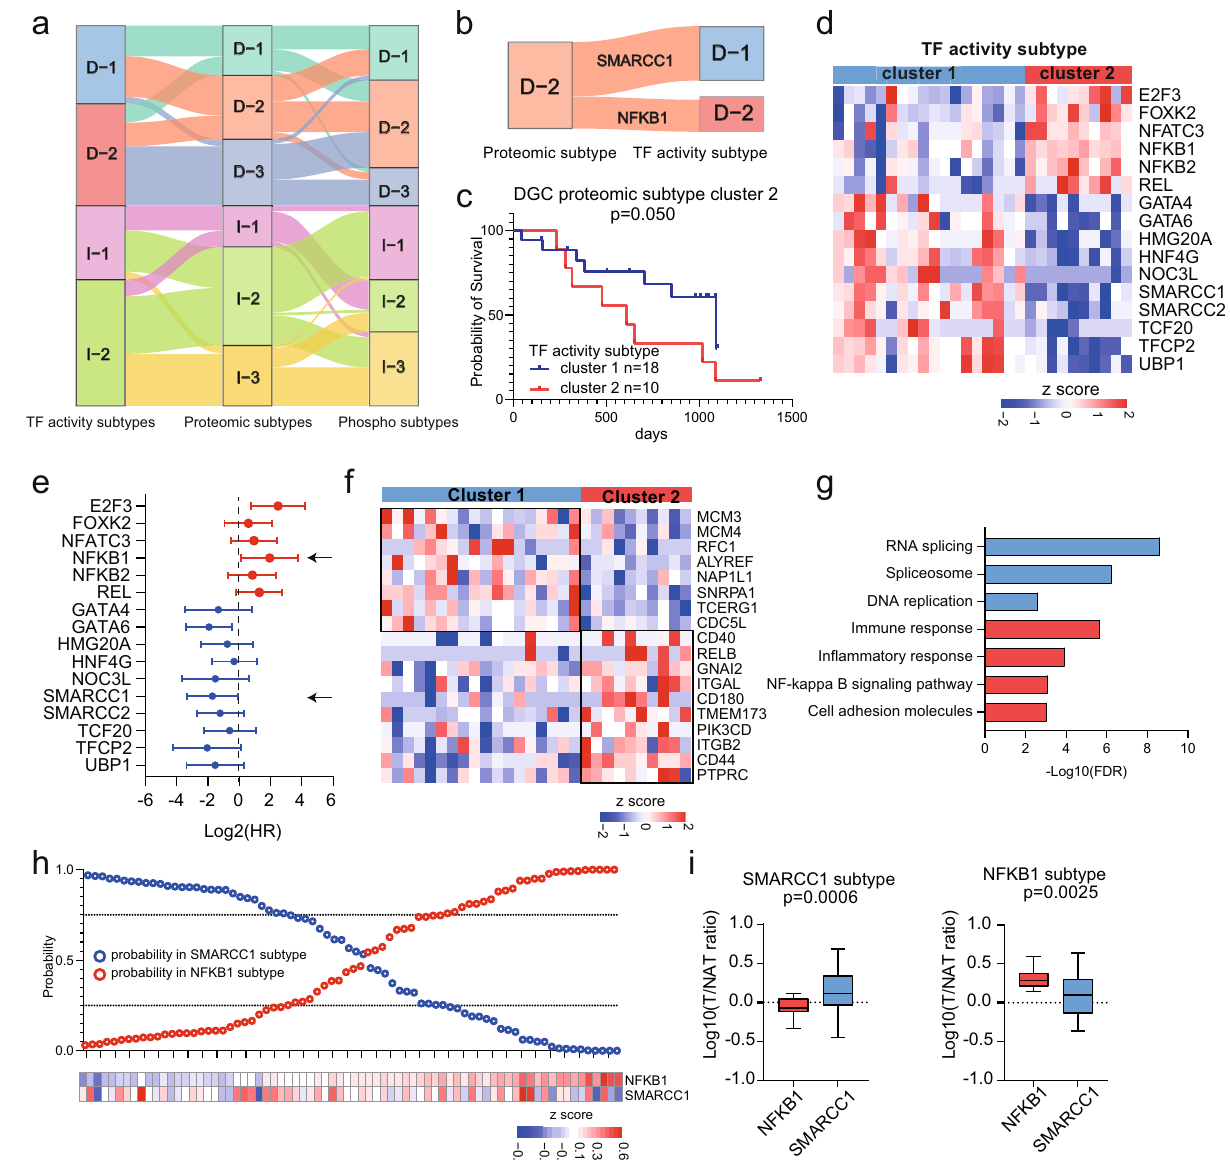
Fig. 6 | Characteristics of Multilevel Proteomic Subtyping and its Robustness. a Sankey diagram depicting the association of samples classi fi ed into TF activity, proteomeandphospho-proteome-basedsubtypes. b Sankeydiagramdepictingthe association of samples classi fi ed into DGC proteomic cluster 2 and DGC TF sub- types. c PrognosticoutcomesofGCpatientsinDGCproteomicsubtypecluster2. n (cluster1)=18 and n (cluster 2)=10 biologically independent samples. The p -value isfromLog-ranktest. d TFactivitiescomparisonbetweentwoTFactivitysubtypes. e Prognostic outcomes of TFs with signi fi cantly differential activities in two TF activity subtypes. n =28 biologically independent samples. The points and error